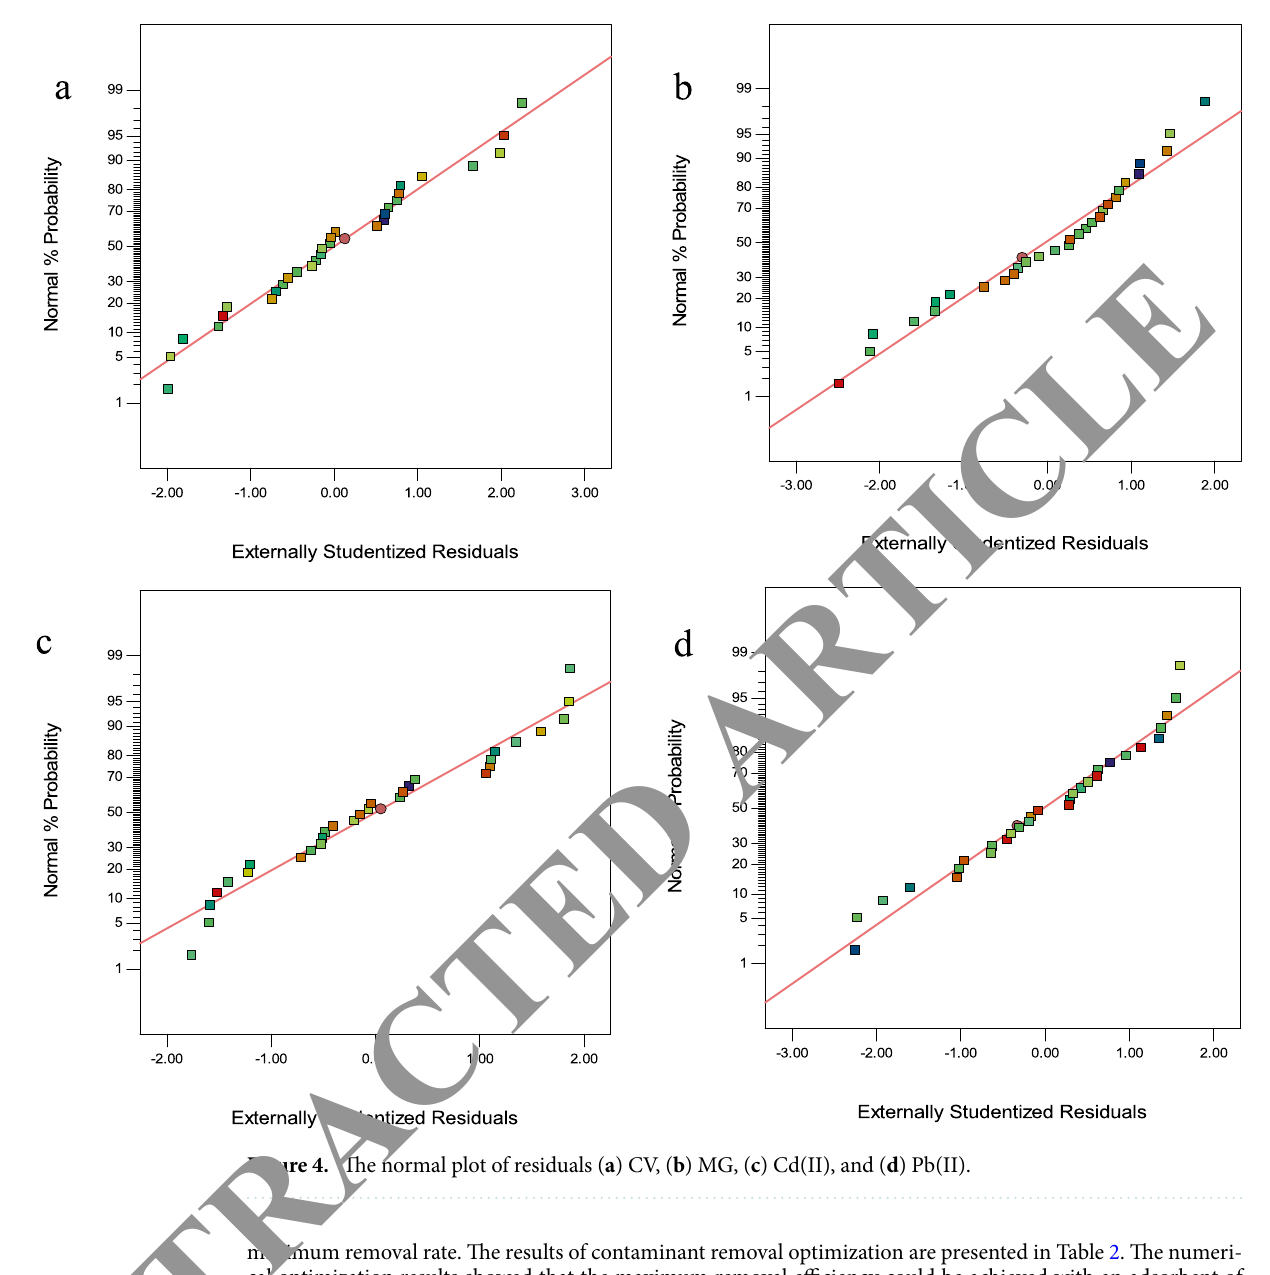
Figure 4. The normal plot of residuals ( a ) CV, ( b ) MG, ( c ) Cd(II), and ( d )